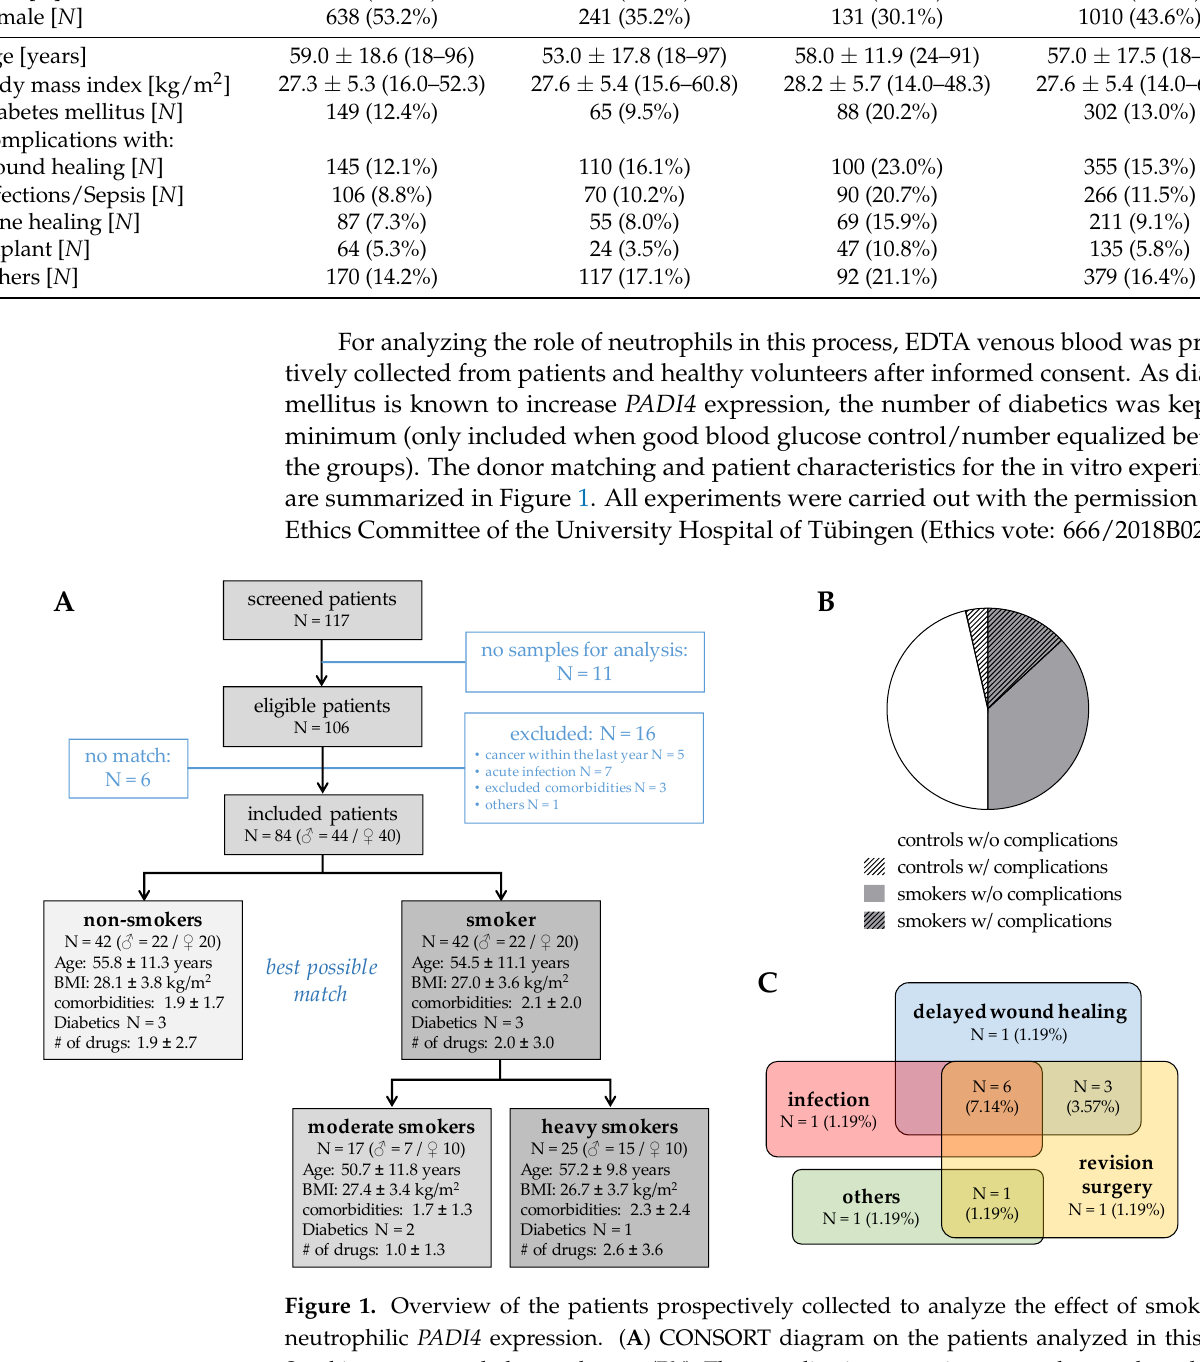
Table 1. Characterization of the patients included in the retrospective data analysis from the hospi- tal information system. Data are presented as absolute numbers [ N ] and percentage or as mean ± standard deviation (range). For complications, one patient might have multiple codings.